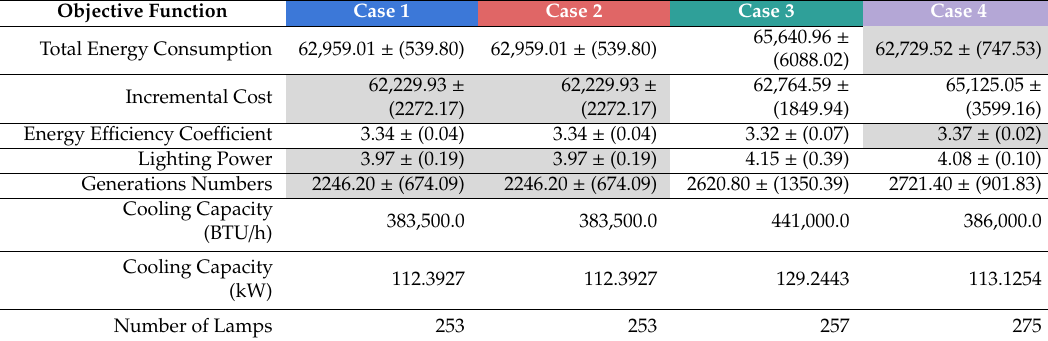
Figure 8. Best individual among all tests performed per case without baits ( a ) showing all 4 cases together and ( b ) without Case 2, the red. Table 6. Evaluation of the results obtained in the experiments to analyze the best case for the fitness function formation of proposed methodology—Without Baits.